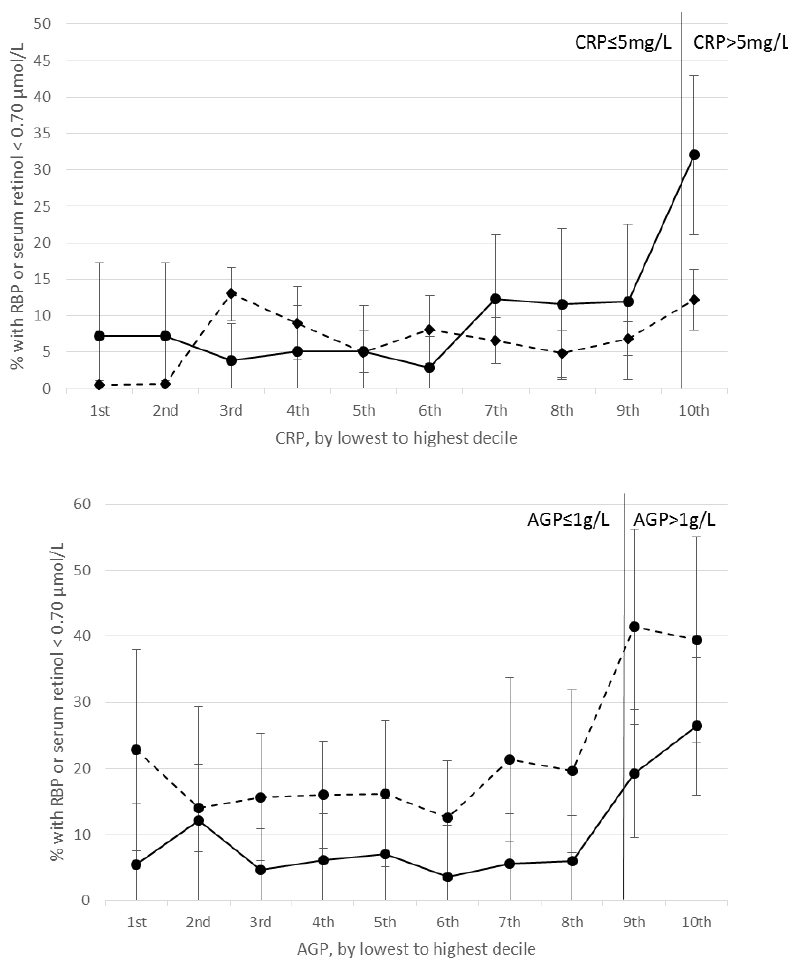
Figure 2. Estimated prevalence (95% CI) of vitamin A deficiency in school age children by CRP ( top ) and AGP ( bottom ) deciles. Top figure: solid line represents prevalence of RBP < 0.70 µ mol/L ( n = 750), dotted line represents prevalence of retinol < 0.70 µ mol/L ( n = 11,341). Bottom figure: Solid line represents prevalence of RBP < 0.70 µ mol/L ( n = 750), dotted line represents prevalence of retinol < 0.70 µ mol/L ( n = 1271). AGP, α 1-acid glycoprotein; CRP, C-reactive protein; RBP, retinol binding protein.